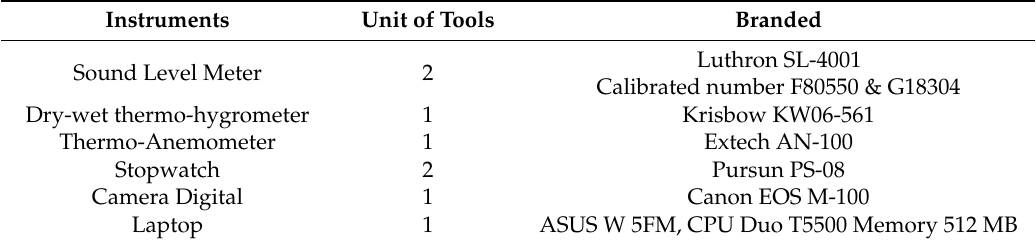
Table 1. Measuring instruments used in the current research.